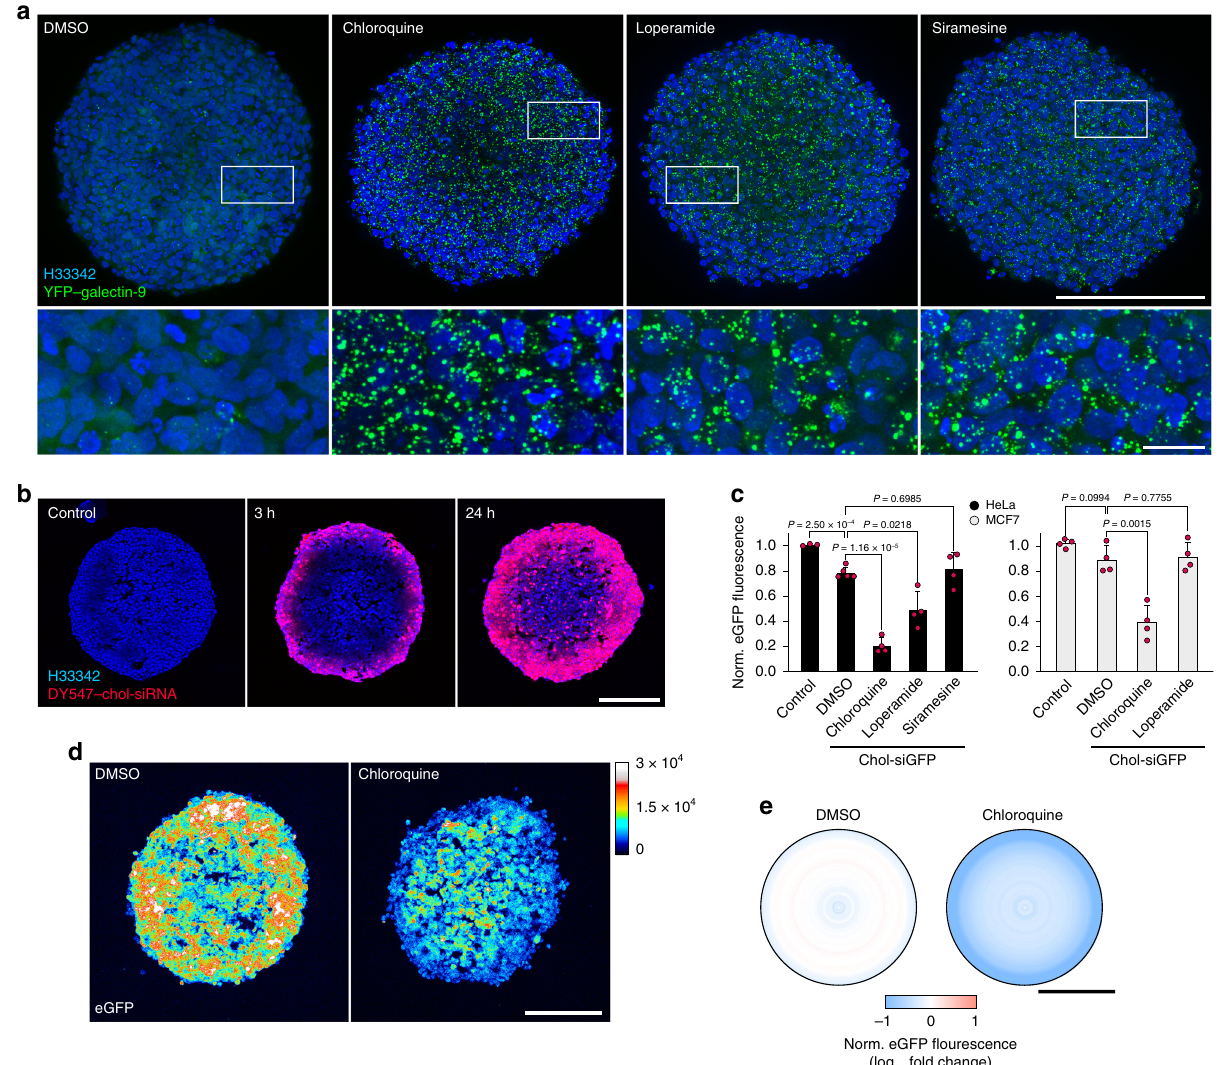
Fig. 9 Induced endosomal damages improves chol-siRNA-mediated knockdown in tumor cell spheroids. a HeLa-galectin-9-YFP cell spheroids incubated with 100 μ M chloroquine, 20 μ M loperamide, or 10 μ M siramesine for 20 h imaged with confocal microscopy after optical clearing. Maximum intensity projections of 45- μ m z -stacks are shown. Images are representative of three independent experiments with at least three spheroids per condition. b Cryosections of HeLa cell spheroids incubated with 1 μ M DY547-chol-siRNA for 3 or 24 h, imaged with confocal microscopy. Maximum intensity projections of 15- μ m z -stacks are shown. Images are representative of at least three spheroids per condition, from three independent experiments. c HeLa- d1-eGFP or MCF7-d1-eGFP cell spheroids were incubated with 1 μ M chol-siGFP and the indicated small molecules for 3 h, followed by 27 h incubation with small-molecule-supplemented medium only. eGFP knockdown was determined by fl ow cytometry after spheroid dissociation. Mean ± s.d. is shown. N = 3 (HeLa control), 5 (HeLa DMSO + siGFP) or 4 independent experiments. Two-tailed Student ’ s t test. d HeLa-d1-eGFP cell spheroids were treated as